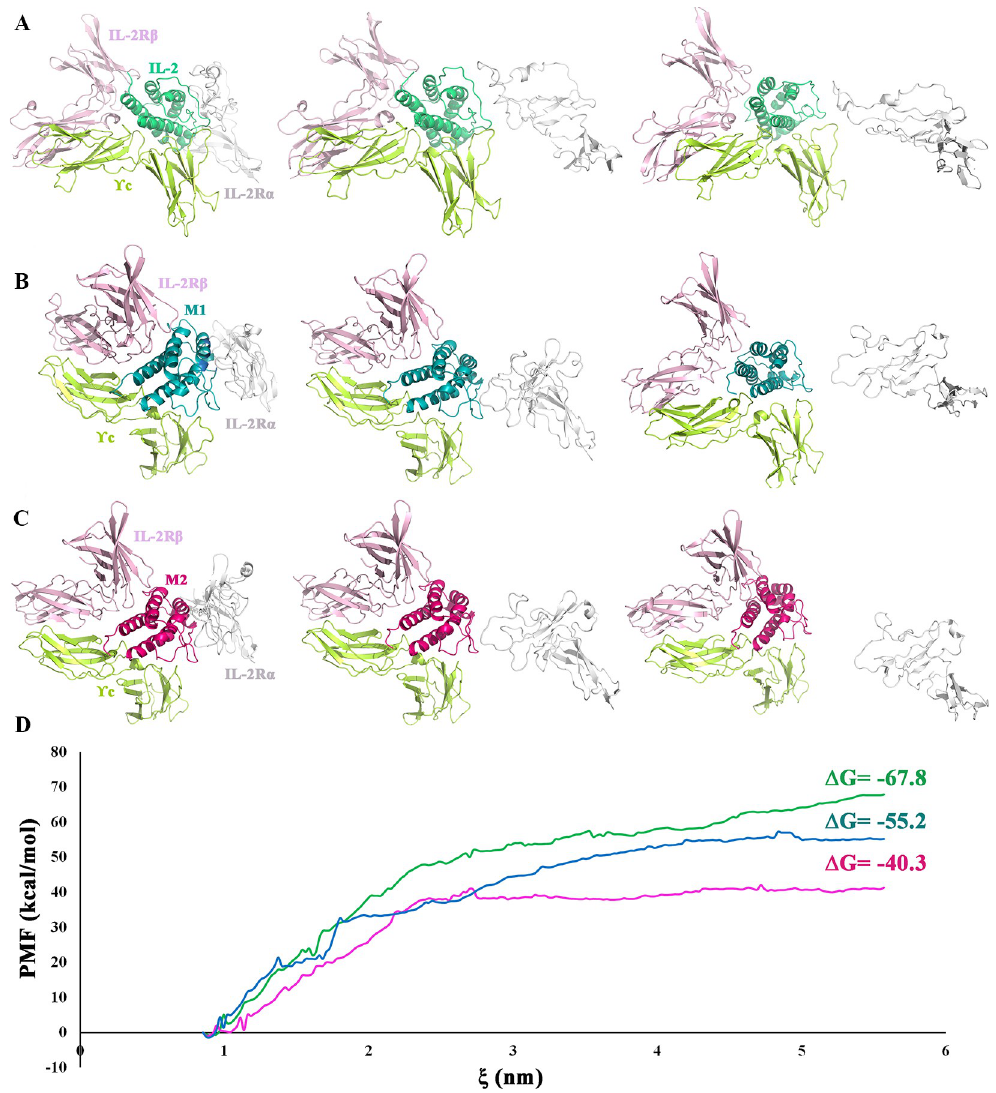
Fig 5. Snapshots of umbrella sampling simulations of the target complex. A. Native IL-2, B. Mutant 1and C. Mutant 2. D. Potentials of mean forces (PMF) for IL-2 and IL-2R α (the native (green), mutant 1 (blue) and mutant 2 (magenta) proteins) as a function of the reaction coordinate ( ξ